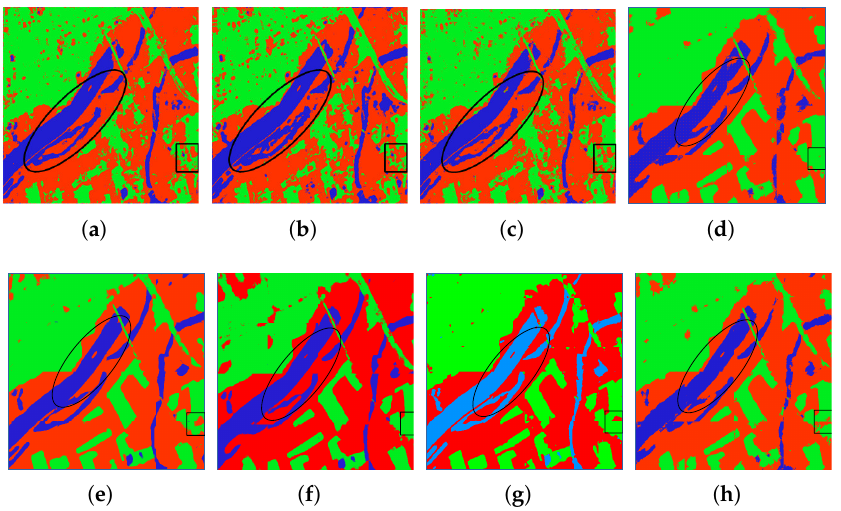
Figure 8. Classification results for the Xi’an dataset with different methods. ( a ) SVM. ( b ) Wishart. ( c ) Bagging. ( d ) CNN. ( e ) SFCN. ( f ) CVFCN. ( g ) Unet. ( h )